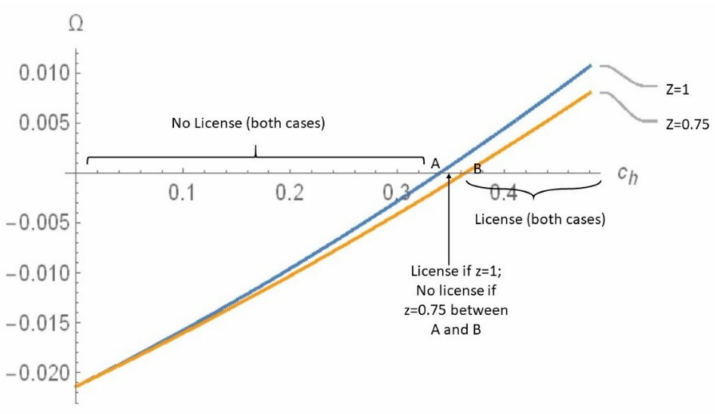
Figure 1. Licensing vs. No Licensing for Cases (i) and